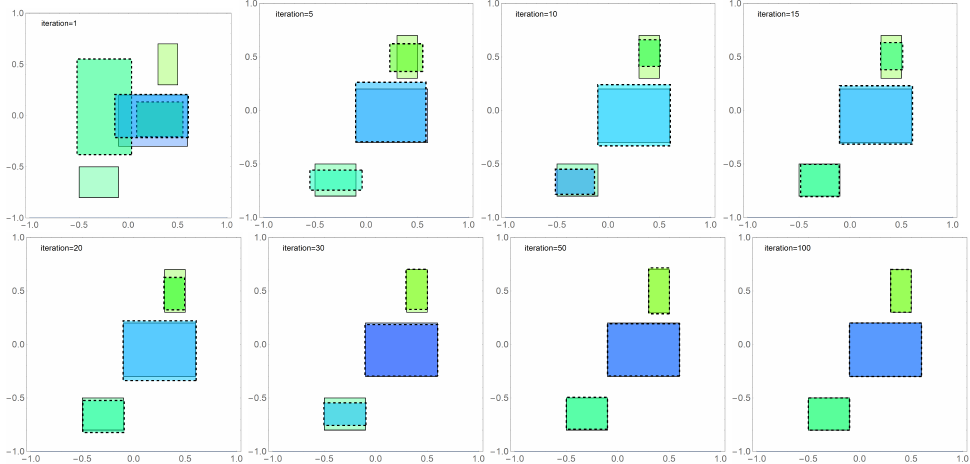
Figure 5. Graphical presentation of the results obtained with the FA algorithm for the population n = 200 in selected iterations, where the reconstructed areas are outlined with a dashed line while the exact solution is outlined with solid line, and the area height is marked by color.